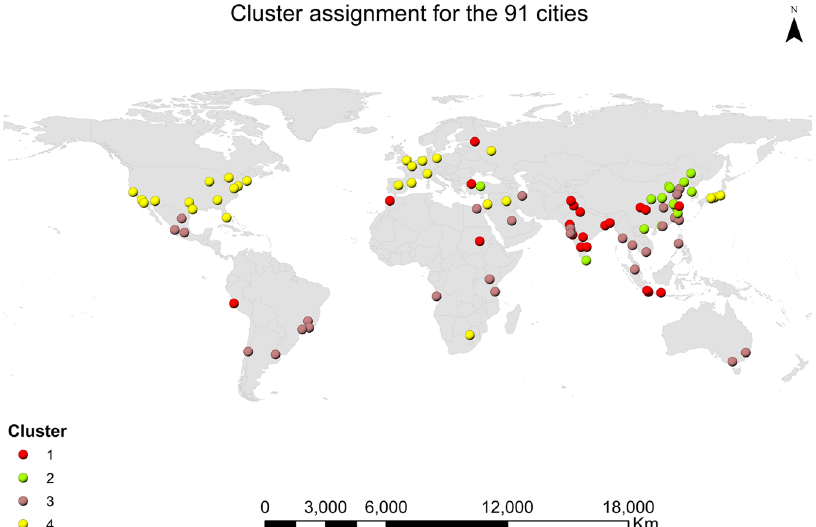
Fig. 3 Cluster assignments for the 91 cities in the study. The clusters are grouped into four and their characteristics are described in Table 3.